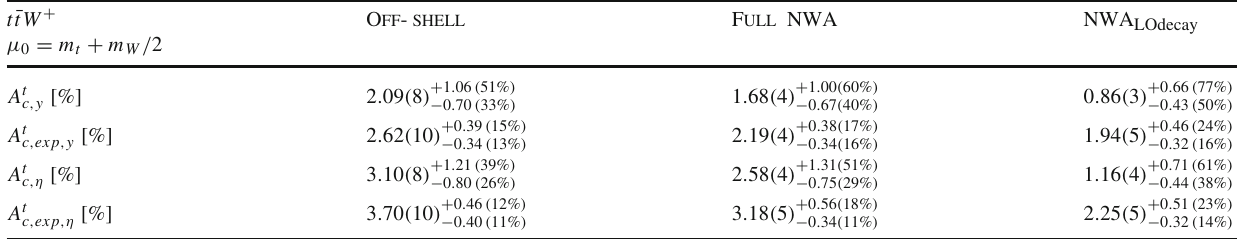
Table 3 Unexpanded and expanded A t c asymmetry at NLO in QCD for pp → t ¯ tW + in multi-lepton channel at the LHC with TeV. Various approaches for the modelling of the top quark production and decays are considered: the full off-shell case, the full NWA and the